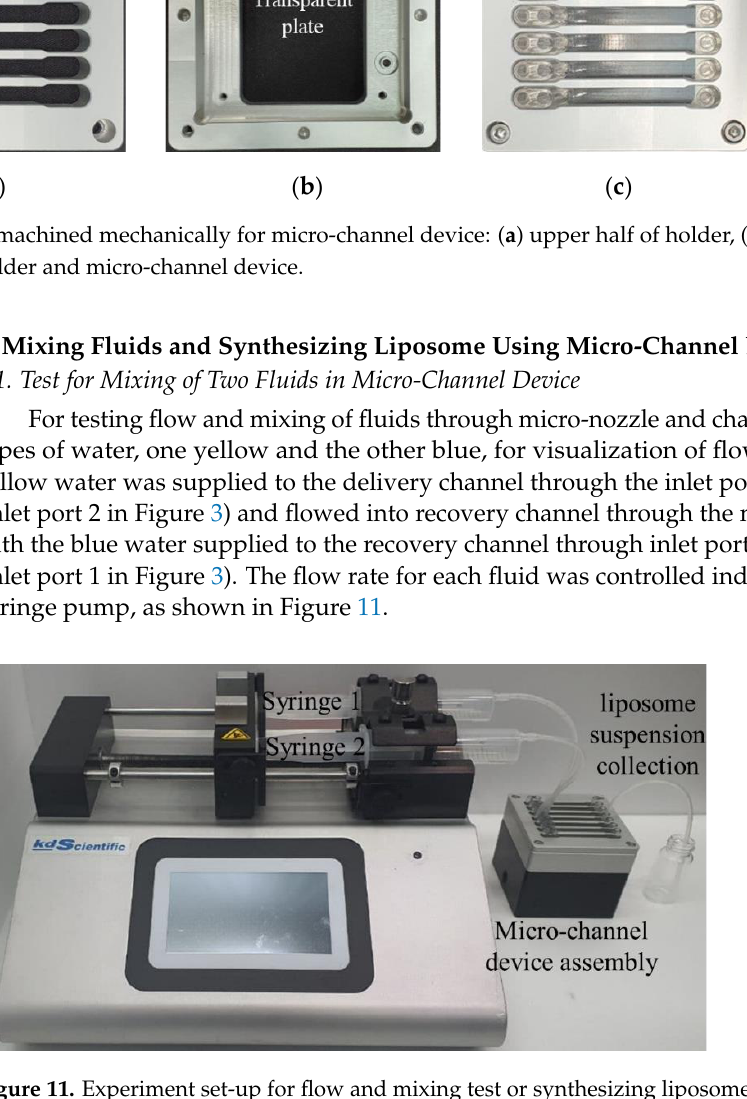
Figure 12. Flow and mixing visualization in micro-channel device. 3.2. Synthesizing Liposome Using Micro-Channel Device SOY PC (95%) (L-α-phosphatidylcholine, Avanti Polar Lipids, Inc., alabaster, AL, USA) and saline (0.85% NaOH solution) were used to synthesize liposome using micro- channel device. A total of 0.775 g of granular SOY PC was mixed with 10 mL of EtOH for 3 h using a magnetic stirrer to produce 10 mM of SOY PC EtOH solution. This SOY PC solution was supplied to the micro-channel device through inlet port 1 at two different flow rates, 3 mL/h and 4.5 mL/h. Saline, 0.85% of NaOH solution, was supplied through inlet port 2 at a 30 mL/h flow rate (Figure 3). Liposome synthesis experiments were re- peated three times, each for a set of flow rate conditions using the same SOY PC EtOH solution and saline. The liposome suspension was heated up to 80 °C for 1 h so that it could be volatilized after being collected through the outlet port from recovery channel where the two solu- tions were mixed. The boiled liposome suspension was cooled down to room temperature and stored in a chamber at 5 °C for 20 h. NANOPHOX (Sympatec GmbH, Clausthal-